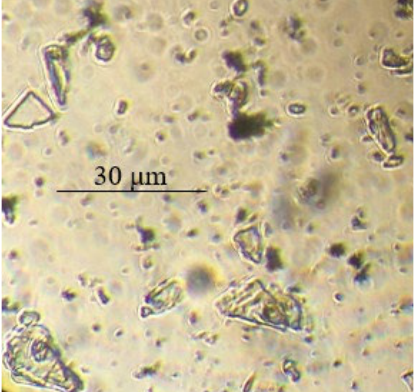
Figure 3. Micrographs of mica ( a ) and core/shell pigment with a mica core ( b ) (20 wt.% of PANi, sulfuric acid used as a dopant).